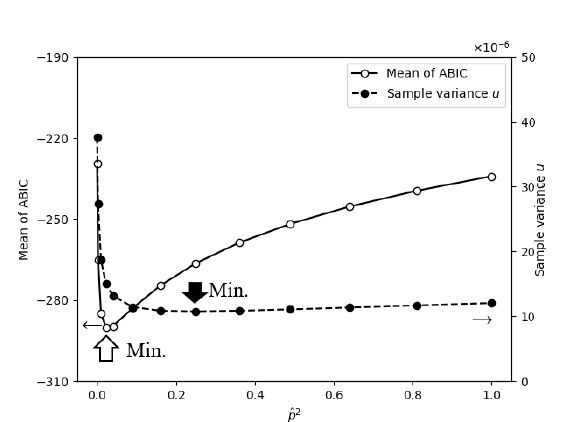
Fig. 12. Relationship between changes in the mean of ABIC and sample variance 𝑢 with changes in the hyperparameters (when 𝐕(cid:3553) 𝐦 (cid:3404) 𝑝 (cid:2870) (cid:3554)(cid:4666)𝐕 𝐦 (cid:3397) 𝑎𝐈(cid:4667) ) 3.2.3 The case o f 𝑽(cid:3561) (cid:3404) 𝒎